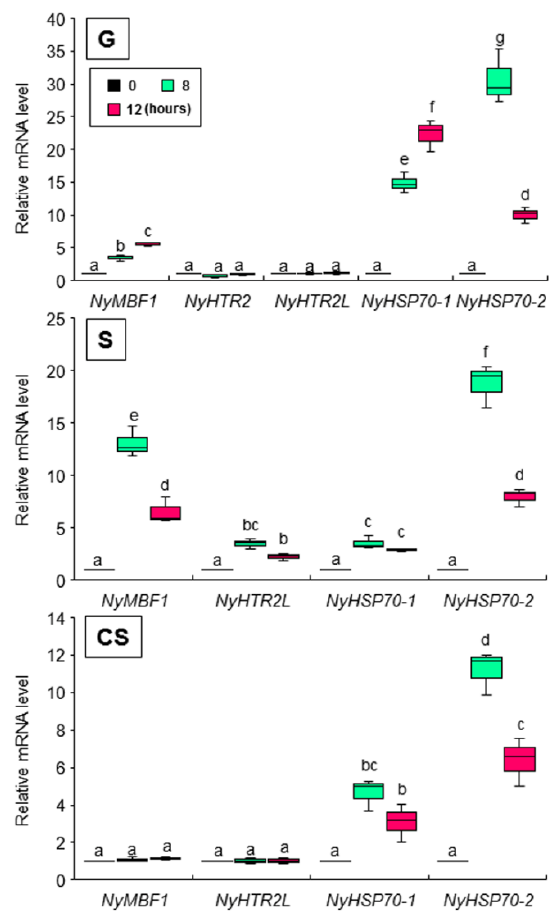
Figure 7. Involvement of membrane fluidization in dark-induced gene expression in three life cycle generations of Neopyropia yezoensis . The algae were treated with 2.5 mM BA, and expression of NyHTR2 , NyHTR2L , NyMBF1 , NyHSP70-1 , and NyHSP70-2 was examined at 8 and 12 h after heat stress (25 ◦ C) exposure under continual light. Relative mRNA levels were normalized using eIF4A as the reference gene. In the box plots, values on the Y axis represent the fold change of relative quantification of each gene. Different alphabetical letters denote significant differences in expression level among the three life cycle generations from triplicate independent replicates as defined by Tukey’s test ( p < 0.05) in two-way ANOVA. G—gametophyte; S—sporophyte;